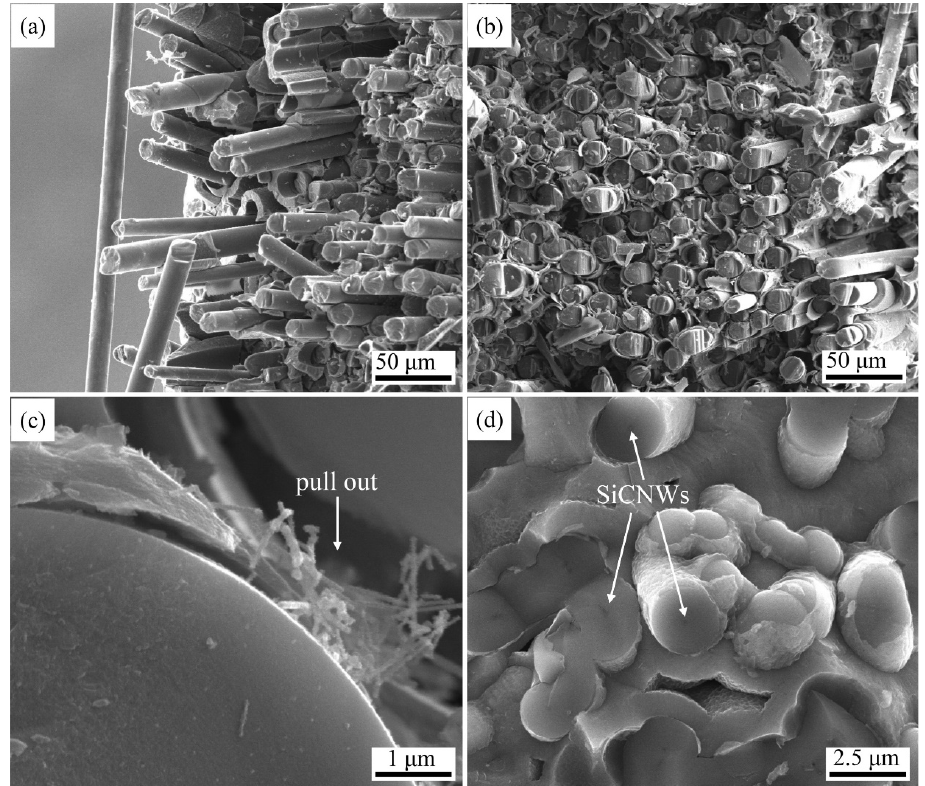
Figure 12. Fracture morphology of SiC f /SiC composites containing SiCNWs after compression tests: ( a ) E-1.5; ( b ) AD-3; ( c , d ) high-resolution images of AD-3.